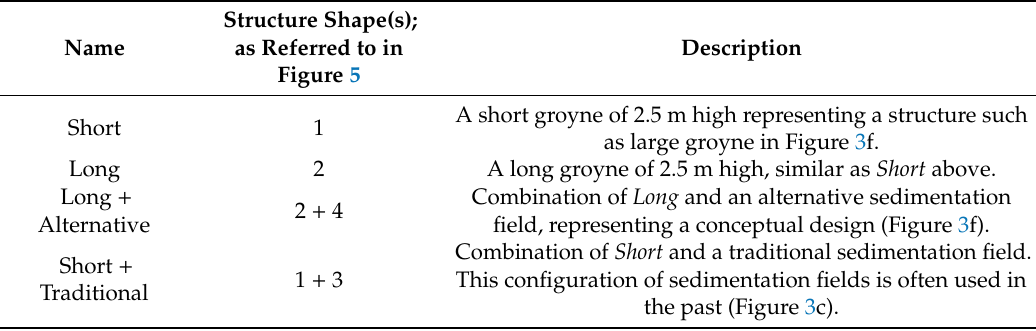
Table 1. An overview of the artificial structure configurations.